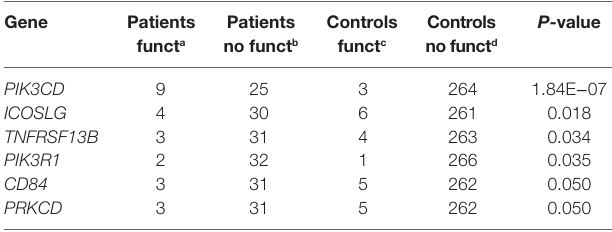
TaBle 9 | Common variable immunodeficiency (CVID) genes with an excess of patients harboring rare functional genetic variants in patients compared to